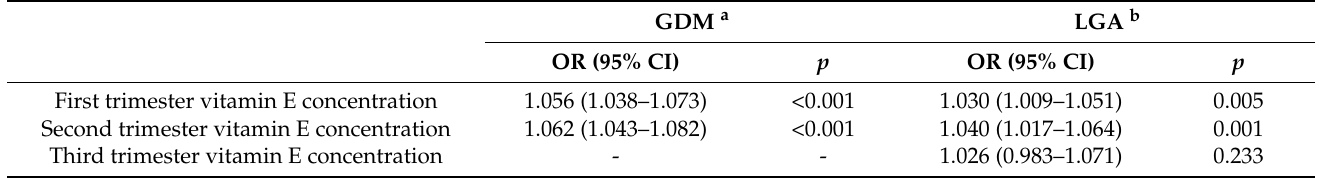
Table 6. The association between vitamin E concentration (continuous variable) and GDM and large for gestational age (LGA), by multivariate logistic